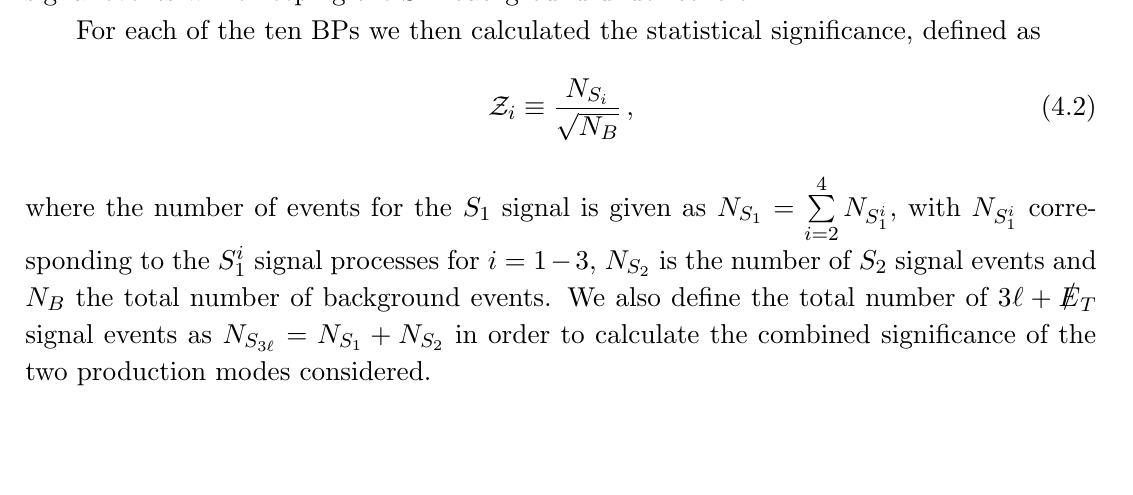
Figure 7. Cumulative number of signal and background events for BP1 versus (a) the invariant mass of the OSSF lepton pair and (b) the transverse mass at the LHC with L = 300 fb (cid:0) 1 . The legend in (a) applies to (b)